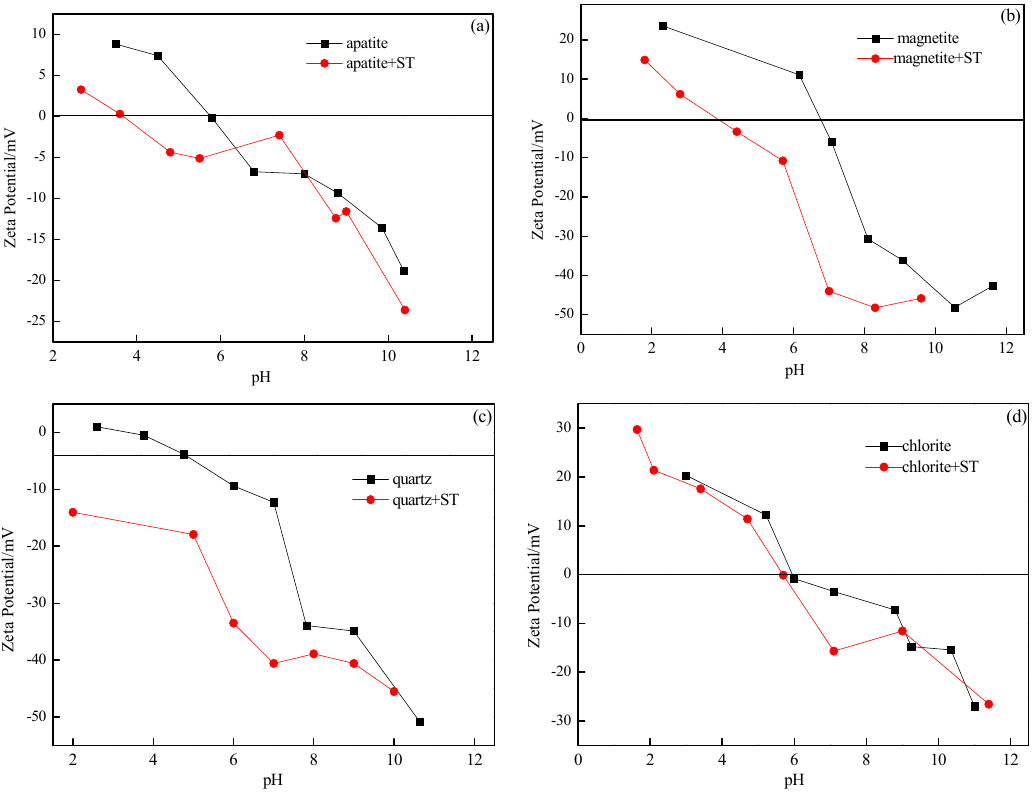
Figure 10. Electrodynamic potential analyses of ( a ) apatite, ( b ) magnetite, ( c ) quartz, and ( d ) chlorite mineral surfaces before and after the addition of toluenesulfonamide(ST).